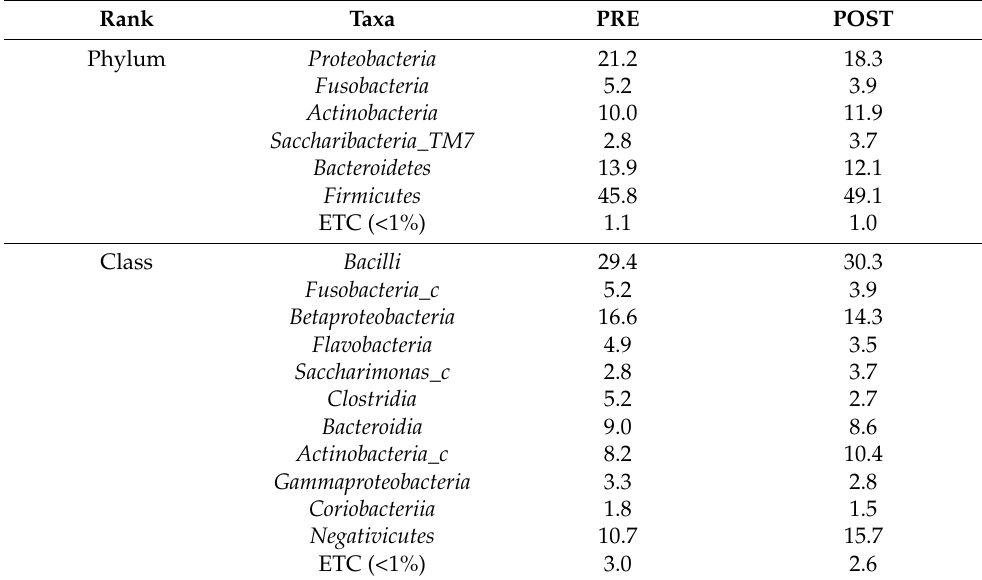
Figure 7. Average taxonomic composition of the salivary microbiome of cancer patients. Taxonomic relative abundance was classified into ( a ) phylum, ( b ) class, ( c ) order, ( d , e ) genus, and when the relative abundance was less than 1%, it was indicated as ETC. The Wilcoxon rank-sum test was used to analyze the significance between the two groups. For all ranks, none of the taxa with a relative abundance greater than 1% had significant changes. Table 7. Distributions of bacterial community at different taxonomic